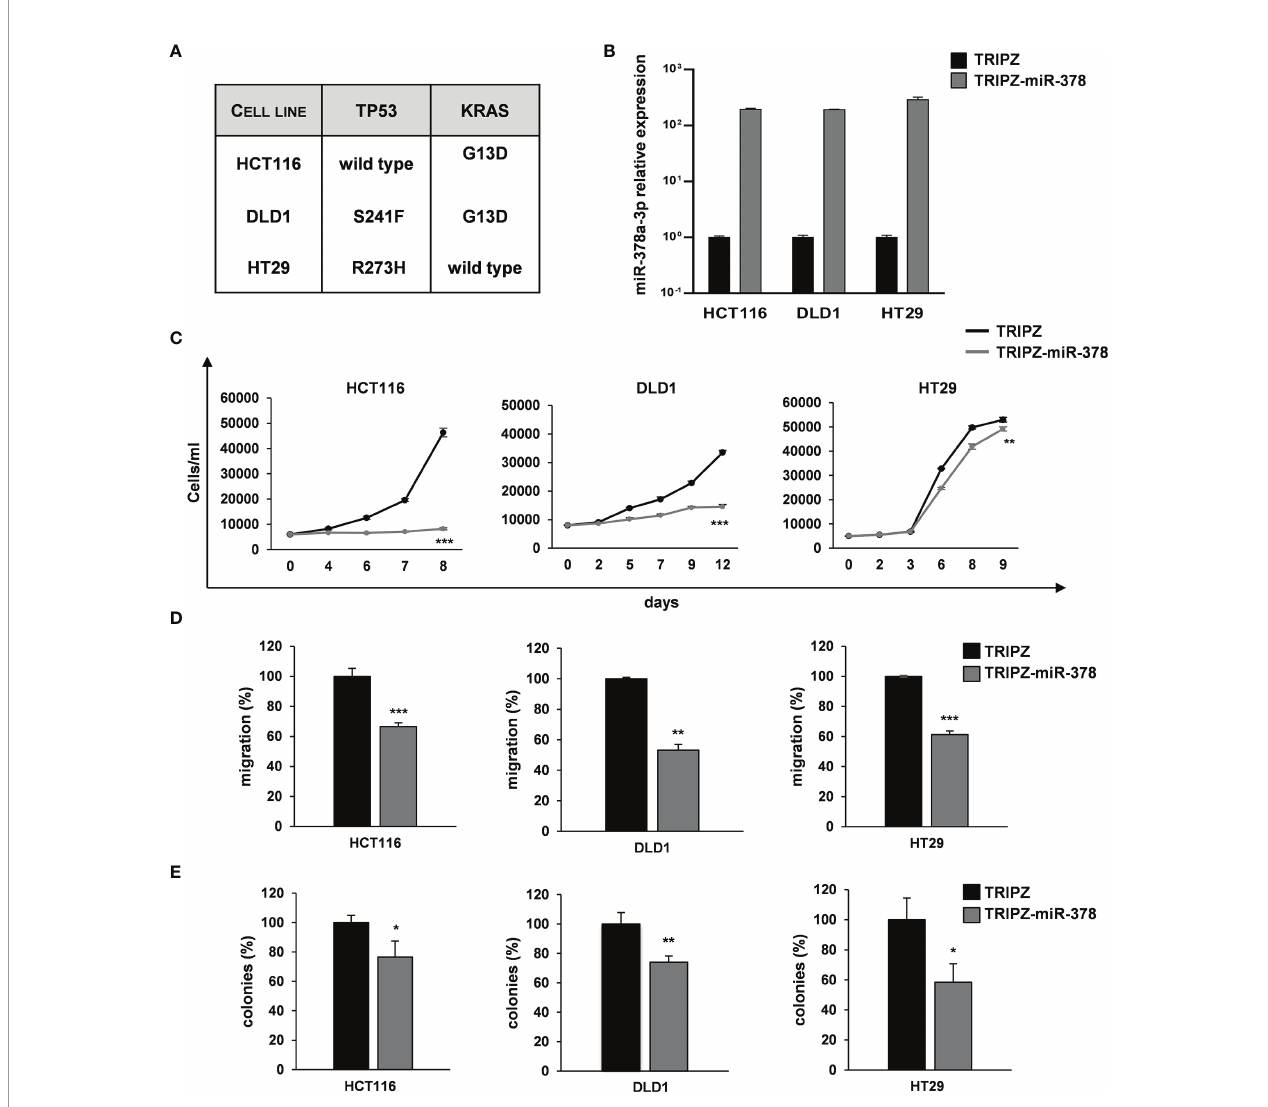
FIGURE 2 | miR-378a-3p restoration reduces cell growth, migration and clonogenic abilities of CRC cell lines. (A) Mutation status of CRC critical genes in selected CRC cell lines (HCT116, DLD1 and HT29). (B) MiR-378a-3p expression was analyzed by qRT-PCR in HCT116, DLD1 and HT29 transduced with TRIPZ or TRIPZ- miR-378 inducible vectors after doxycycline exposure. (C) Growth curves of HCT116, DLD1 and HT29 cells transduced with either TRIPZ or TRIPZ-miR-378 vector. Points and range lines at each day represent mean ± SD of at least two independent experiments in triplicate. (D) Migration assay of HCT116, DLD1 and HT29 cells transduced with TRIPZ or TRIPZ-miR-378 vector. Values are reported as percentage relative to control vector and shown as mean ± SD from two independent experiments in triplicate. (E) Colony formation assay of HCT116, DLD1 and HT29 cells transduced with TRIPZ or TRIPZ-miR-378 vector. Percent colony number values from two independent experiments in triplicate were calculated over the correspondent TRIPZ vector and are shown as mean ± SD for each CRC cell line. *p<0.05, **p<0.01; ***p<0.001 based on Student ’ s t